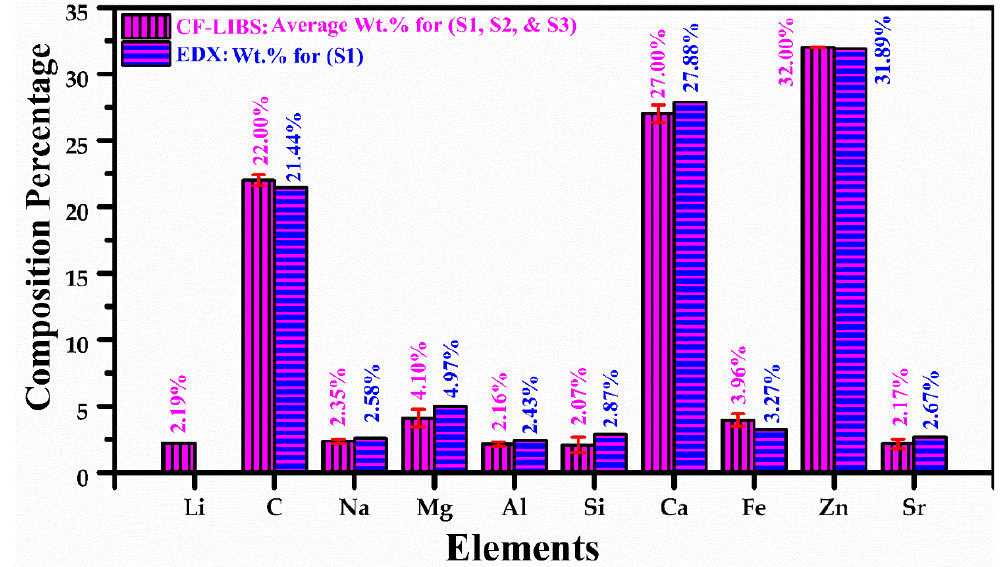
Figure 9. Bar graph showing average elemental composition percentage of the plant-biochar samples (S1, S2, and S3) using CF-LIBS technique and comparison with EDX.